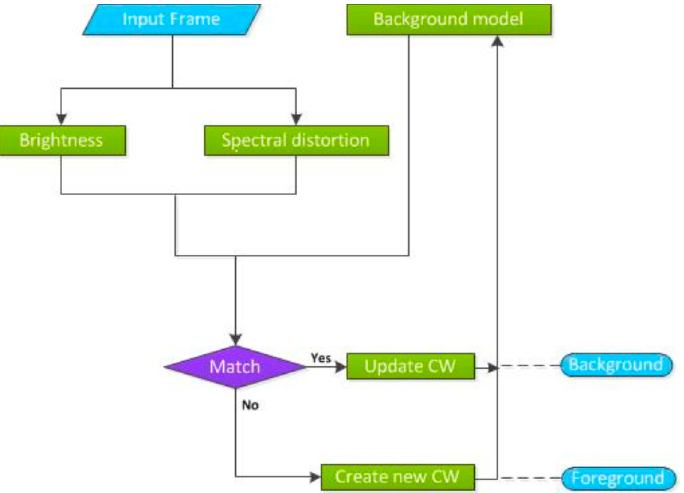
Figure 2. Codebook algorithm.